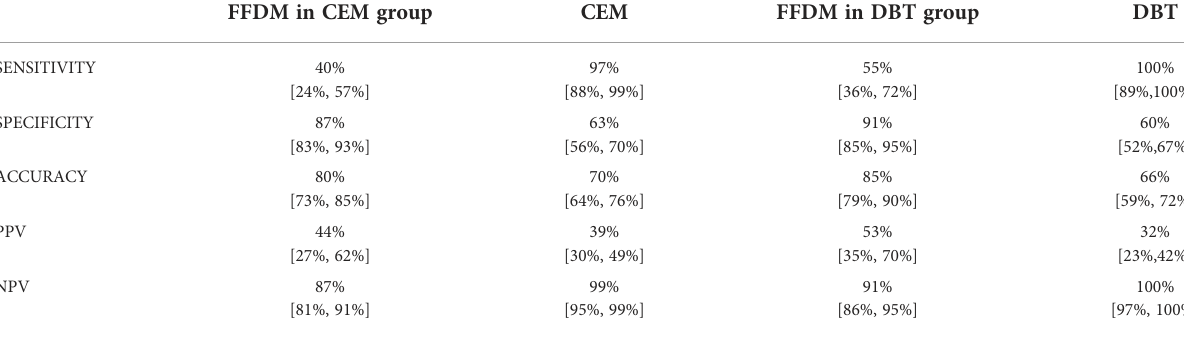
TABLE 3 Sensitivity, speci fi city, accuracy, PPV and NPV levels according to BI-RADS assessment. 95% con fi dence intervals are presented in brackets.